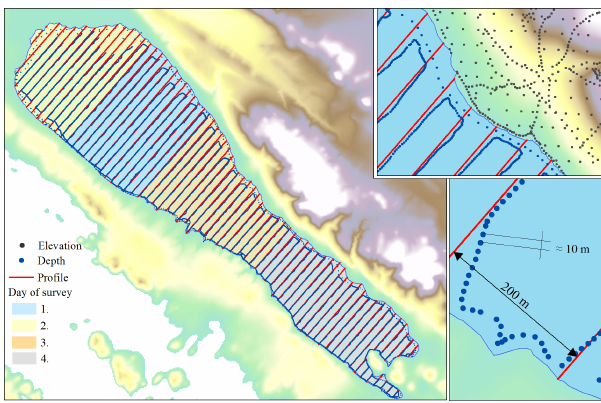
Figure 5. The phases and plan of the bathymetric